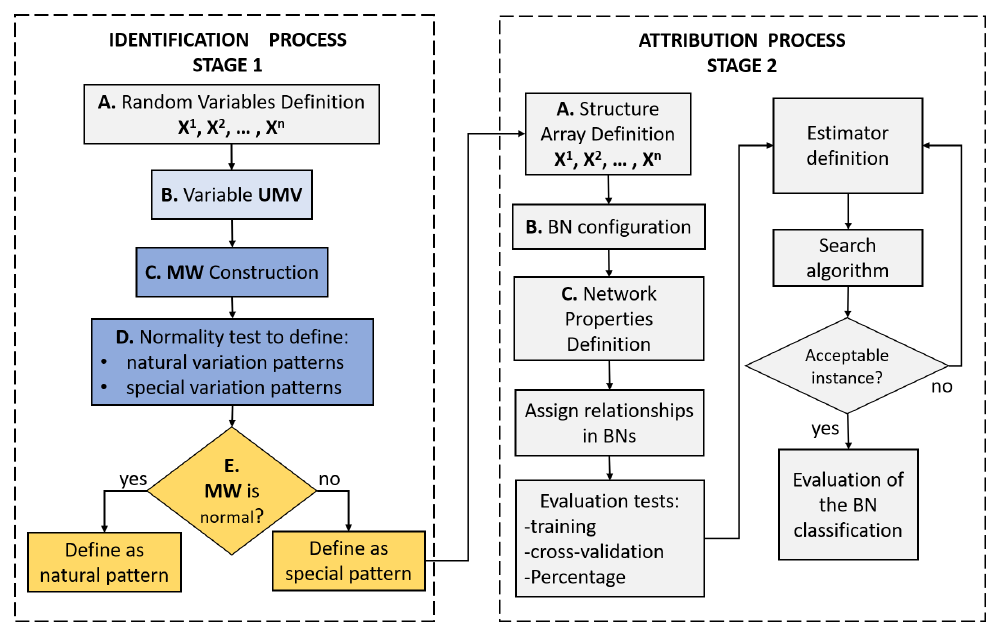
Figure 3. Model for Multivariate Pattern Recognition